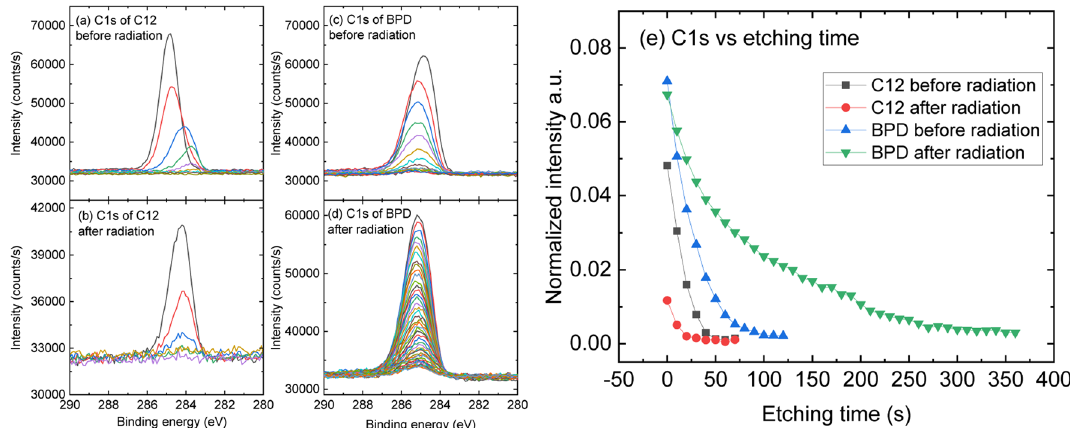
Figure 2. ( a – d ) Evolution of C1s core level spectra as function of etching time for C12 ( a , b ) and BPD ( c , d ) SAMs before ( a , c ) and after ( b , d ) the electron irradiation. The C1s signals are attenuated with increasing number of etching levels, which are presented from top to bottom (etching time ranging from 0 to 60 s for C12 and 0–160 s (0–350 s after the irradiation) for BPD). ( e ) Normalized intensities (normalized with the substrate Au4f signal at the respective etching level) of C1s spectra as a function of the etching etching behaviors after the electron irradiation for C12 and BPD SAMs are shown in Fig. 2b,d, respectively. In the C12 case, the irradiation-induced structural deterioration can be deduced as it costs only 3 etching periods (totally 30 s) to completely remove the C1s signal (see Fig. 2b), compared to 60 s to achieve the same effect on the as-assembled C12 SAMs (Fig. 2a). On the contrary, the BPD SAM after the irradiation is quite resistant to the Ar + beam with the same energy: while it needs 120 s of etching on the pristine BPD SAM (Fig. 2c), a total of 360 s is applied until the BPD SAM signal is mostly removed after the irradiation (Fig. 2d). Figure 2e summarizes our findings regarding the effect of electron-irradiation on the stability of the con- sidered SAM structures, where we plot the intensities of the C1s signal normalized to the Au4f signal at each etching level as a function of the etching time. From the comparison, one can clearly observe the intensity loss and structure deterioration for C12 SAM upon the irradiation. For example, 50 s of etching time is needed for complete removal of the as-assembled C12 molecules from the substrate (black squares in Fig. 2e), whereas it takes 25 s to remove the molecules after electron irradiation (red circles in Fig. 2e). In addition, the C1s signal intensities are always smaller in the latter case. The C1s signal of as-assembled BPD molecules are observed up to 100 s of etching time (blue triangles in Fig. 2e), which is twice longer than the one obtained for the C12 molecules. Interestingly, the etching time required for the removal of the BPD SAM increases dramatically after electron irradiation: C1s signal is observed even after 350 s of etching (green triangles in Fig. 2e). Such an enhanced stability is related to intermolecular cross-linking of the BPD molecules during the electron irradiation 18 .